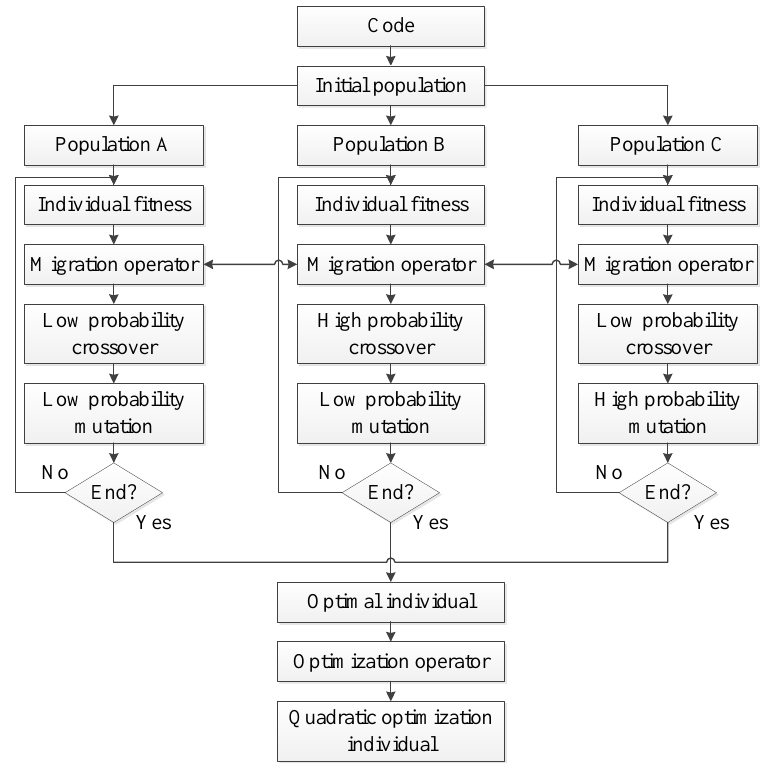
Figure 1. MPMGA frame diagram.